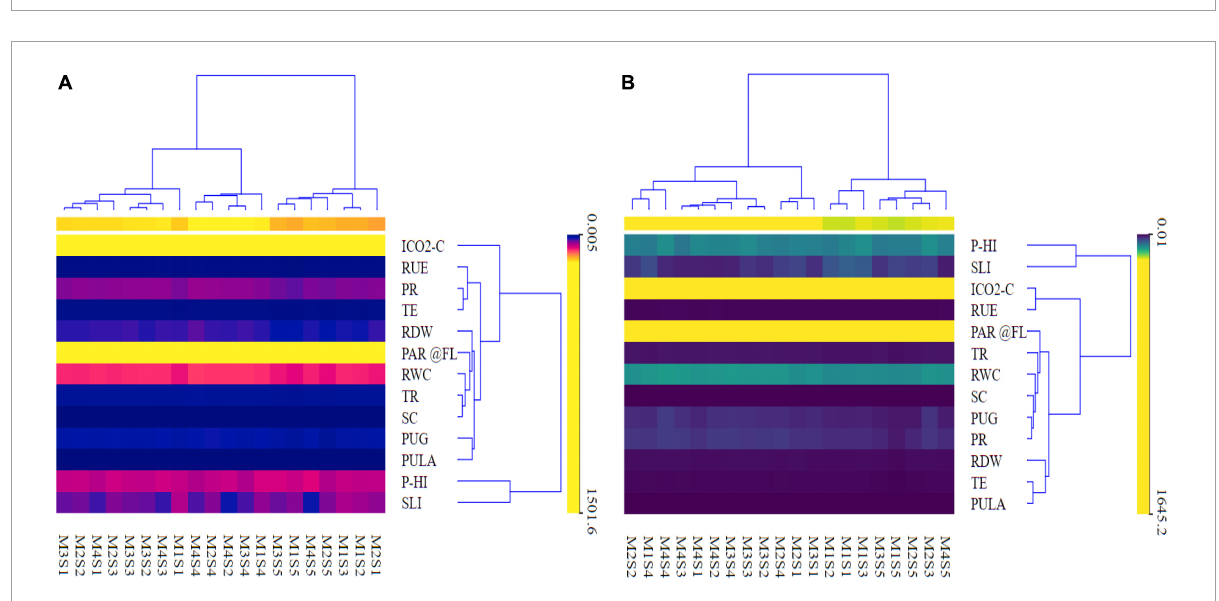
FIGURE9 A clustering heat map depicting different photosynthetic indices, RUE, RWC, and grain-P uptake maize (A) and wheat (B)